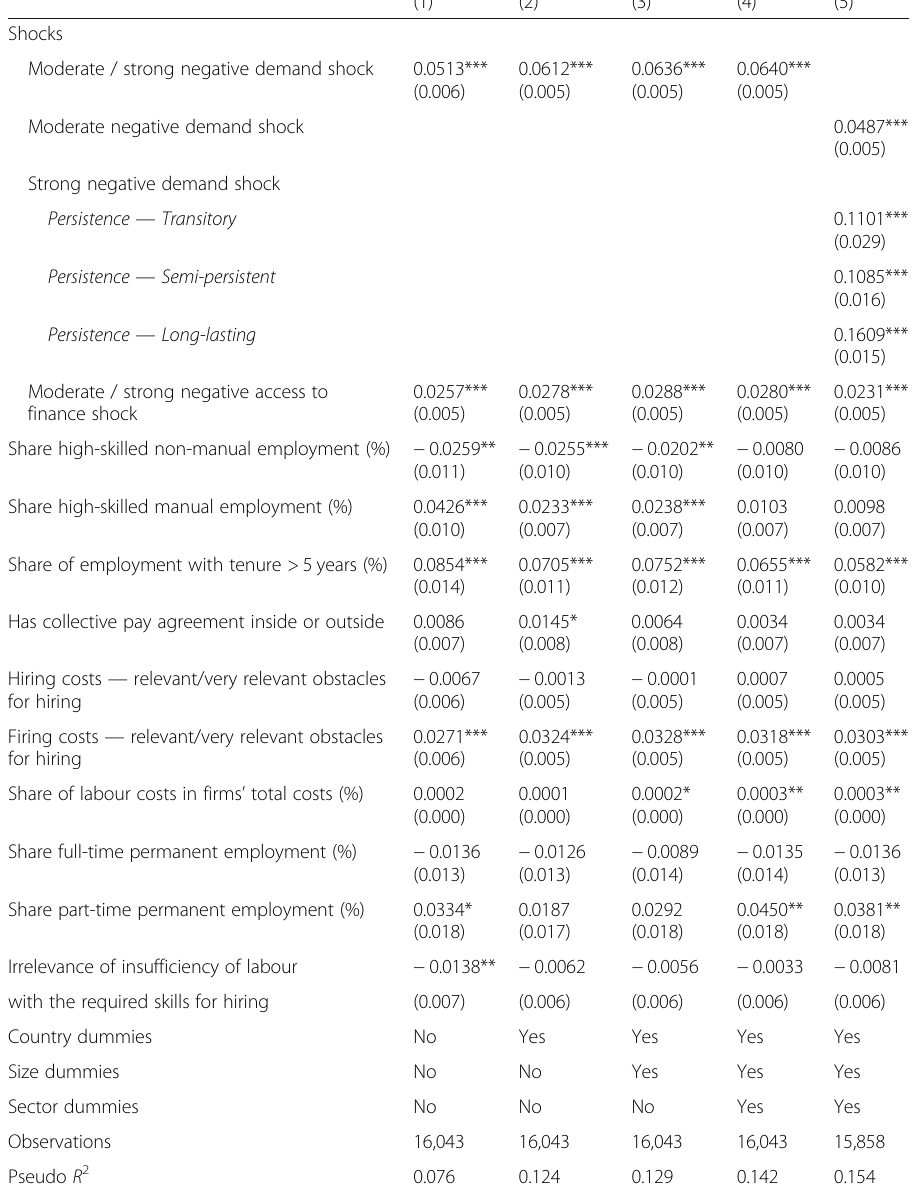
Table 3 Logit results of STW take-up: firm-specific characteristics (marginal effects) (1) (2) (3) (4)